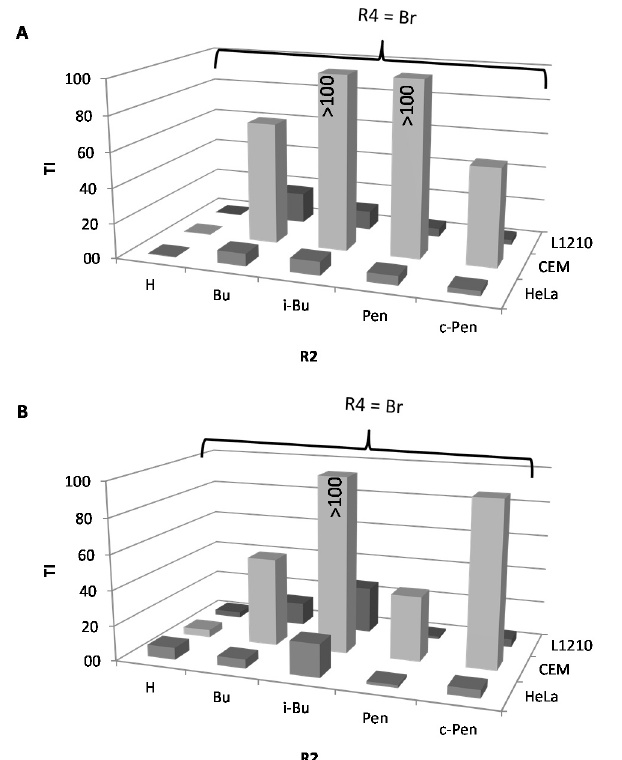
Figure 4. Effect of introduction of an intermediate length (cyclo-)alkyl chain (Bu, i -Bu, Pen, c-Pen) at the 2 N -position of 5-( p -bromophenyl)-2-aminoimidazole (compound 5 ) on the therapeutic index (TI) with respect to Salmonella Typhimurium biofilm inhibition ( A ) and Pseudomonas aeruginosa biofilm inhibition ( B